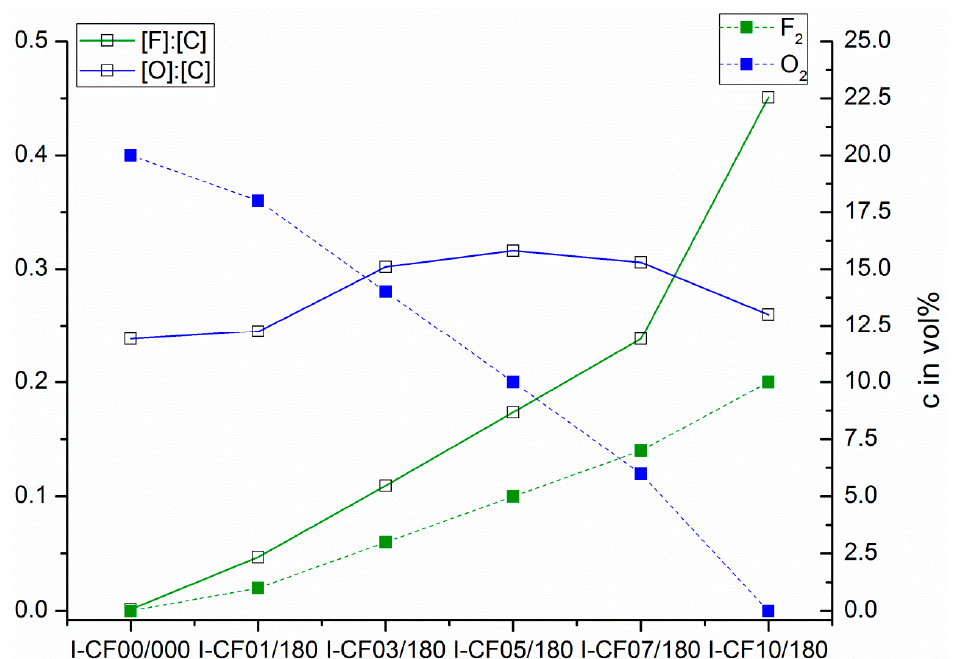
Figure 6. Relative amounts of oxygen ([O]:[C]) and fluorine ([F]:[C]) in dependence on the fluorine content in the process gas used to modify carbon fiber samples. content in the process gas used to modify carbon fiber